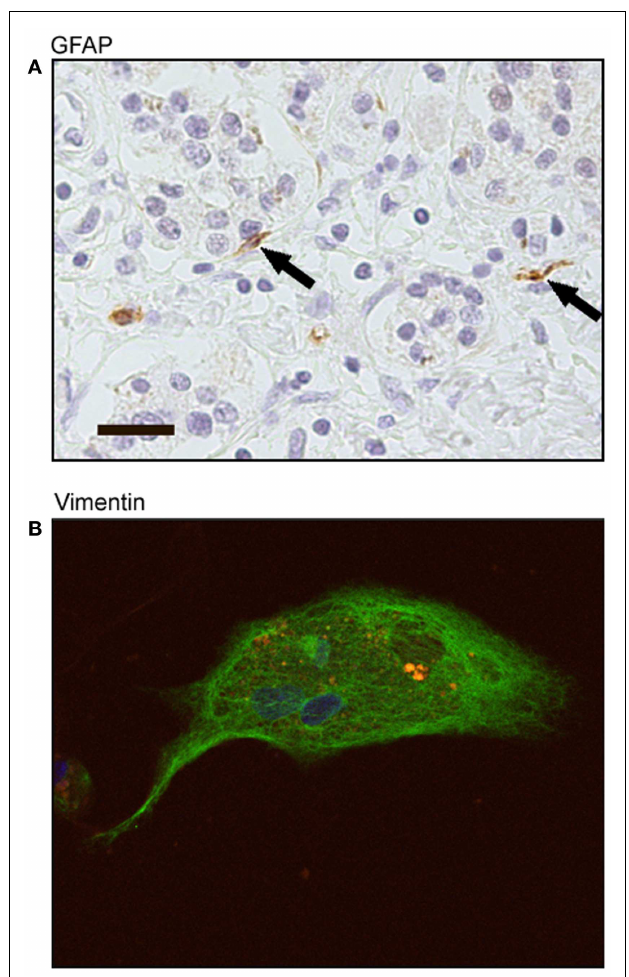
FIGURE 3 | Histology and morphology of human tumor-derived pancreatic stellate cells . (A) Representative phase-contrast image of human tumor-derived pancreatic stellate cells in monolayer after 72h in culture. EUS-FNAs were placed in standard cell culture conditions, resulting in the outgrowth of myofibroblast-like cells.These stellate cells are characterized by a flattened angular appearance, the presence of cytoplasmic lipid droplets, long cytoplasmic processes giving them a typical “stellate” appearance, and cytoplasmic expansion and contraction behavior. (B) Representative hematoxylin/eosin (H&E) stained section and phase-contrast bright field images from time-lapse movies of cell cultures from patients with locally advanced, unresectable pancreatic adenocarcinoma before treatment (pre) and at 6months following treatment with gemcitabine (G) and stereotactic radiosurgery (SRS) (post). White arrowheads point to cytoplasmic lipid droplets; black arrows point to lipid-droplet containing pancreatic stellate cells; white arrows point to other non-stellate cells in culture; black arrowheads point to pancreatic ductal adenocarcinoma cells. Scale bar: 50 µ m.